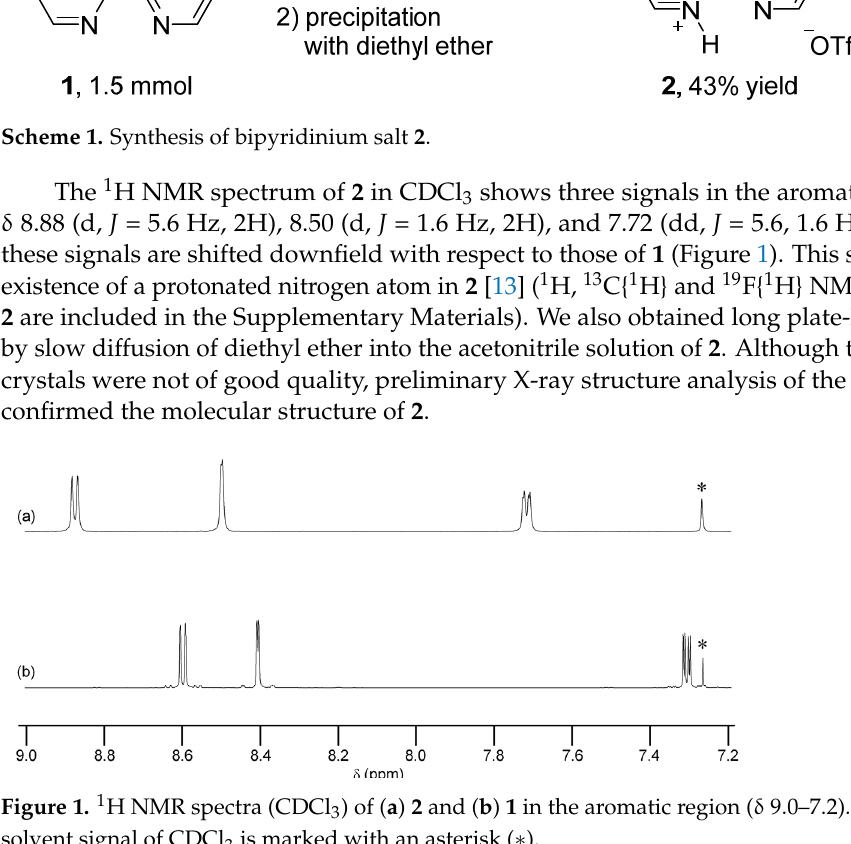
Figure 1. 1 H NMR spectra (CDCl 3 ) of ( a ) 2 and ( b ) 1 in the aromatic region ( δ 9.0–7.2). The residual solvent signal of CDCl 3 is marked with an asterisk ( ∗ ).